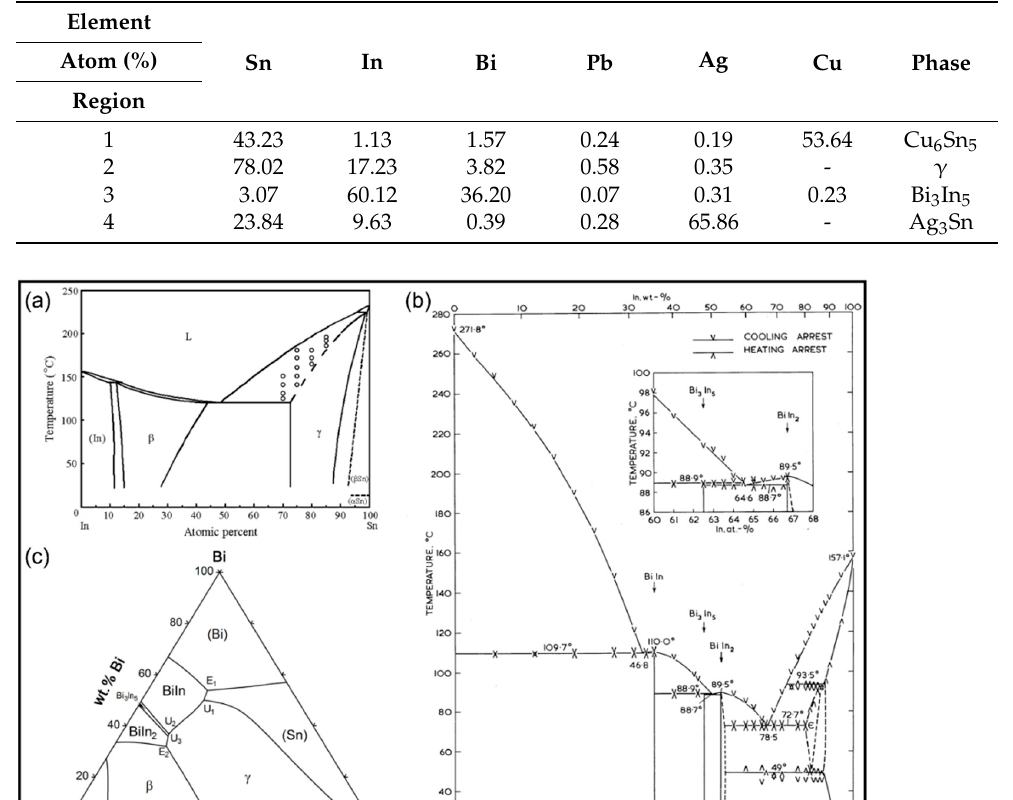
Table 2. Element content of the regions marked in Figure 7.